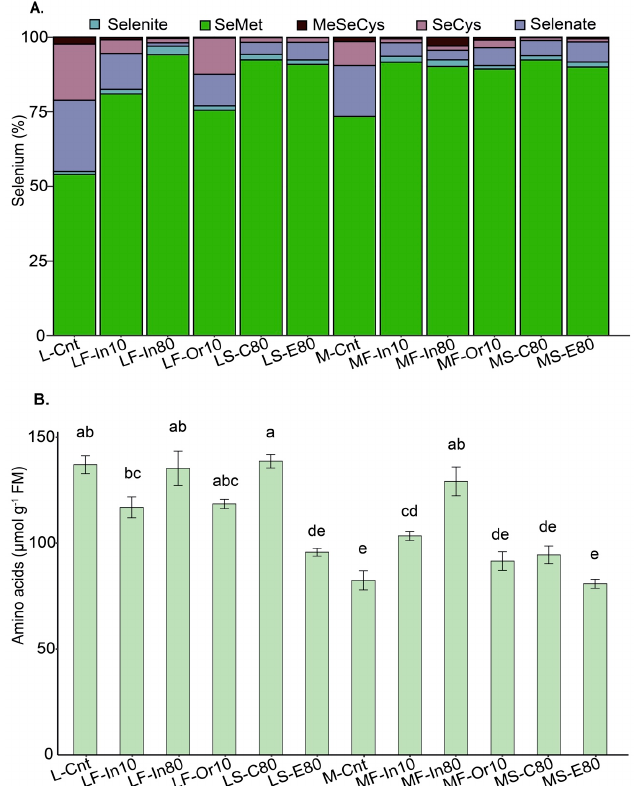
Figure 2. Selenium species (%) ( A ) and amino acids ( μ mol g − 1 FM) ( B ) in soybean grains from biofortified plants growing under different methods of selenium application. Lowercase letters compare Se contents and Se recovery among the treatments at the level of 5% by the Tukey test. The vertical bars represent the standard error ( n = 4). Genotype: L = Lança and M = M5917; Se application: F = foliar and S = soil; Se source: In = Se inorganic, Or = Se organic, C = C-MAP + Se, and E = E-MAP + Se; Rate: 10 = 10 g ha − 1 and 80 = 80 g ha − 1 ; Cnt = control.